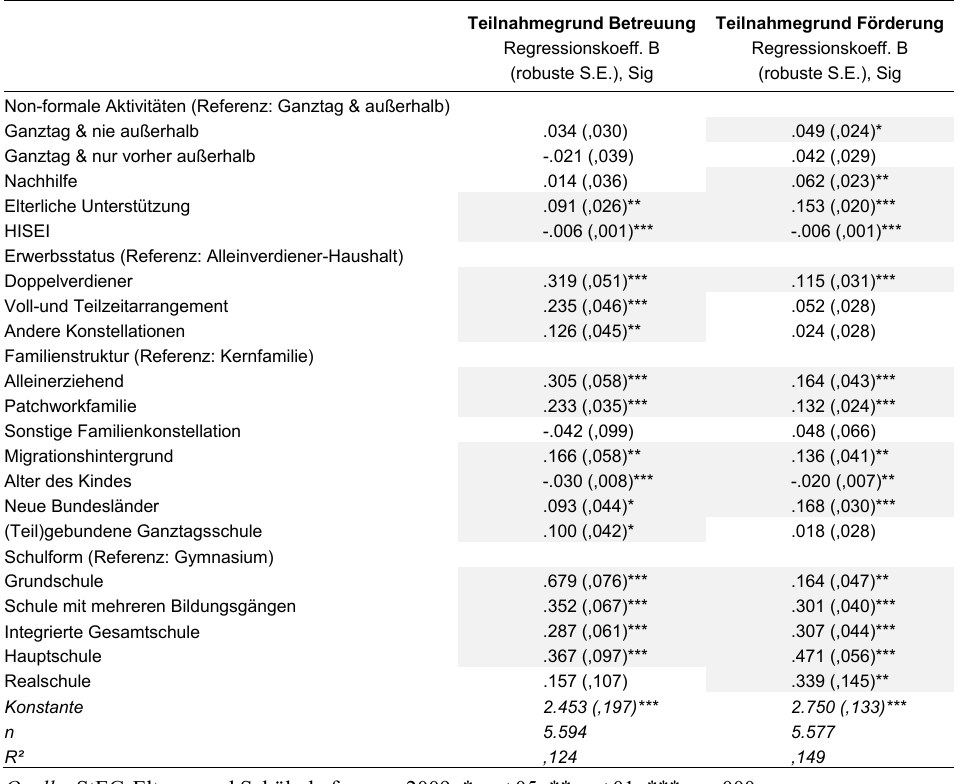
Tabelle 5 : Prädiktoren für den Teilnahmegrund Betreuung und den